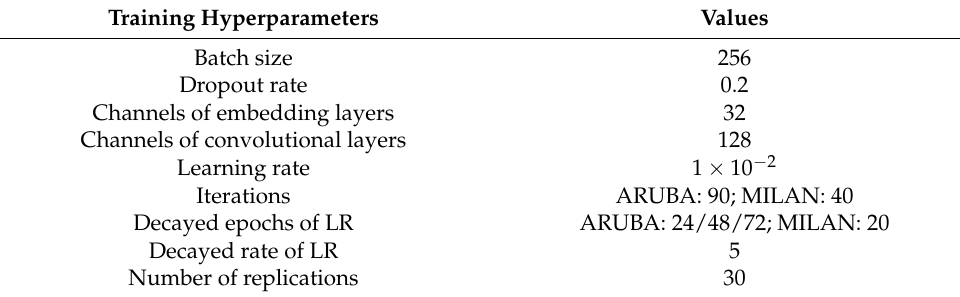
Table 2. Training hyperparameter settings. Training Hyperparameters Values Batch size 256 Dropout rate 0.2 Channels of embedding layers 32 Channels of convolutional layers 128 Learning rate 1 × 10 − 2 Iterations ARUBA: 90; MILAN: 40 Decayed epochs of LR ARUBA: 24/48/72; MILAN: 20 Decayed rate of LR Number of